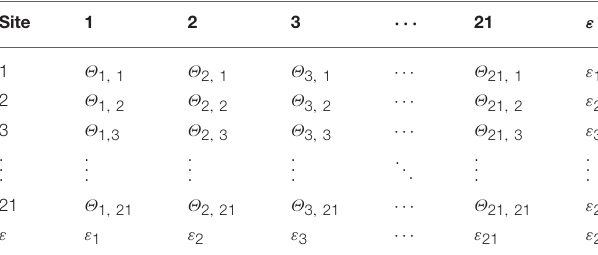
5.61, df = 37, P < 0.05), resulting in the following linear model TABLE 3 | Example transition matrix containing probabilities ( Θ ) of dispersal movement among 21 discrete forest sites, and functional emigration ( ε ) from the study